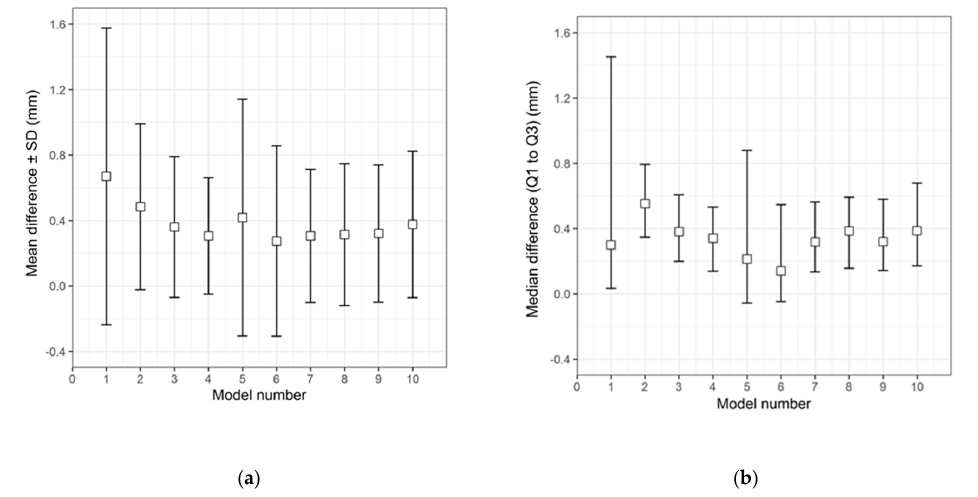
Figure 3. Descriptive data distribution illustrating the difference between the CRD-PSIs (models 1 to 10) and the CRD 3D printed template. ( a ) Mean difference ± SD (mm); ( b ) Median difference (Q1 to Q3) (mm).